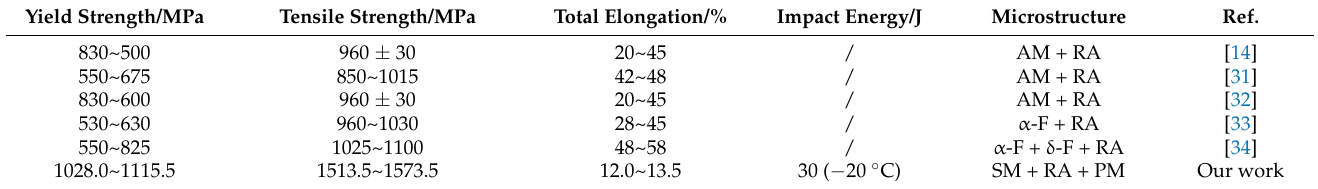
Table 5. Typical mechanical properties and microstructures compared to our